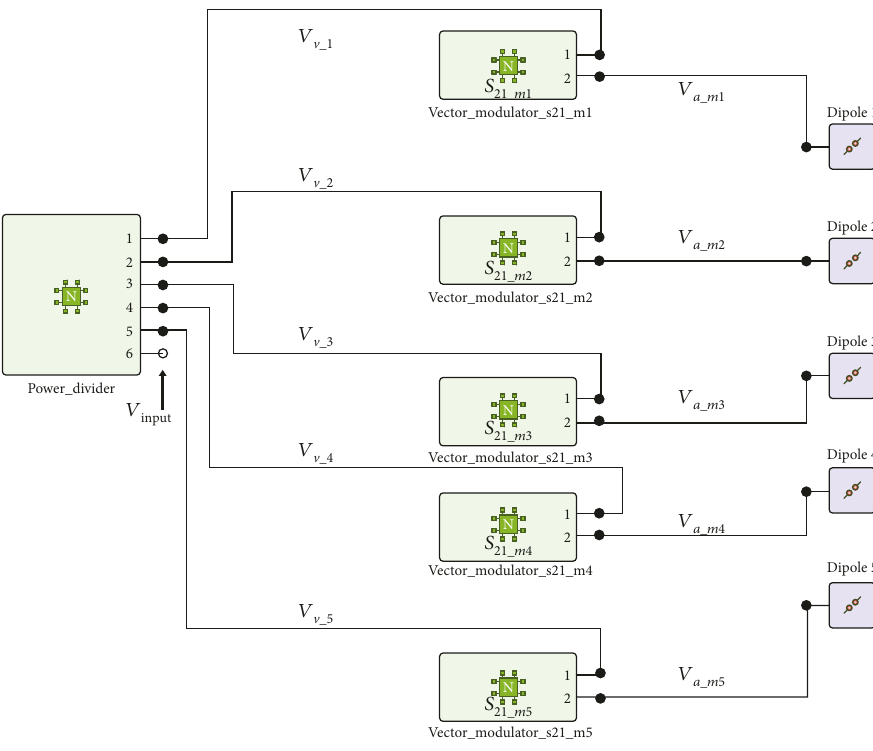
Figure 4: FEKO model of the transmission system